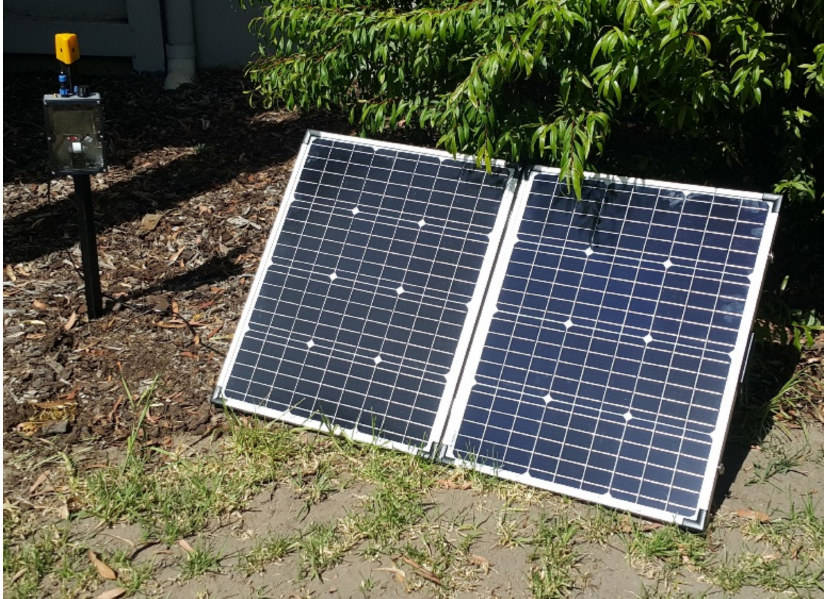
Figure 6. Camera trap setup consisting of camera trap mounted on stake, recording the ground, and solar panel powering the